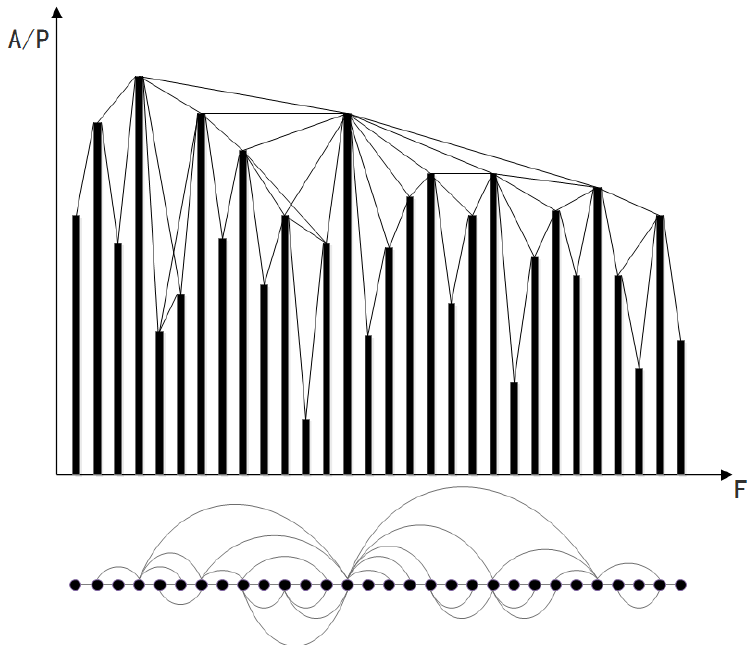
Figure 4. The VG construction process for frequency series CSI